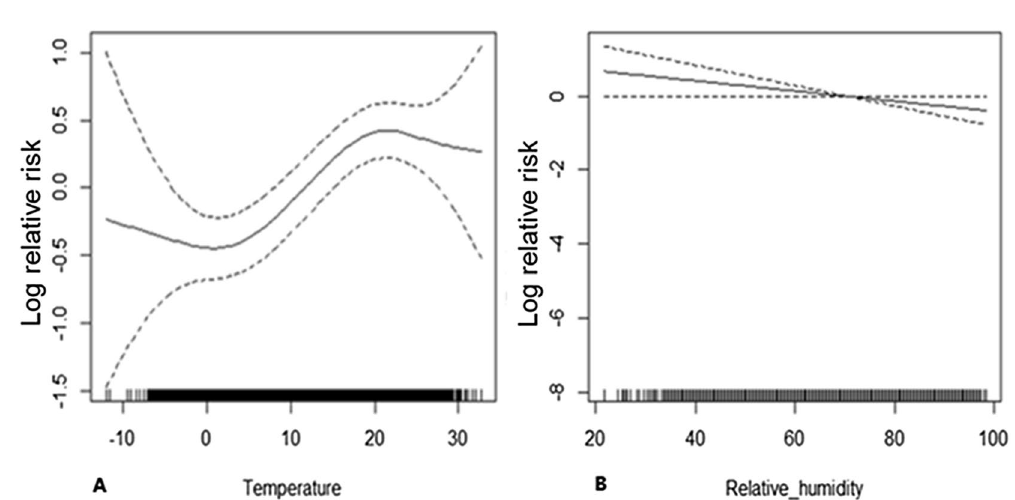
Figure 5. (A) Relationship between temperature and disease risk. (B) Relationship between relative humidity and disease